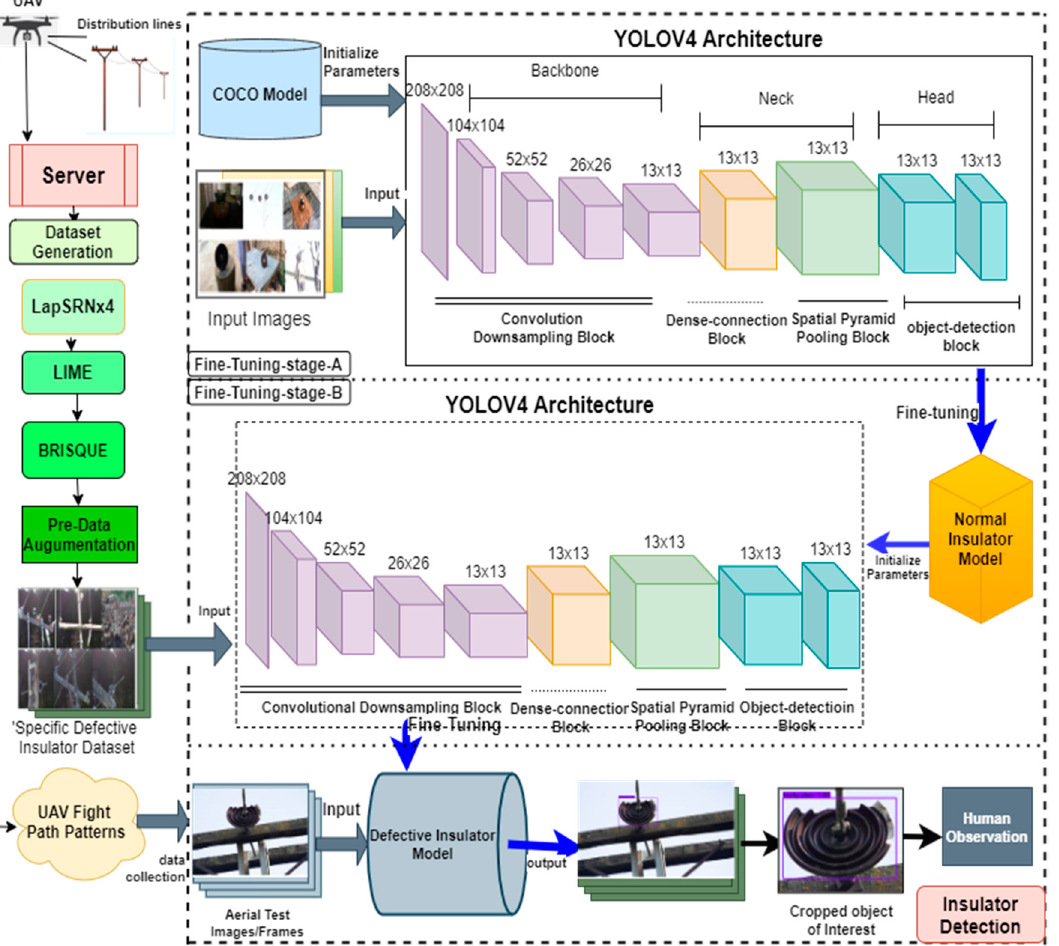
Figure 12. Fine-tuning strategy for insulator detection model.